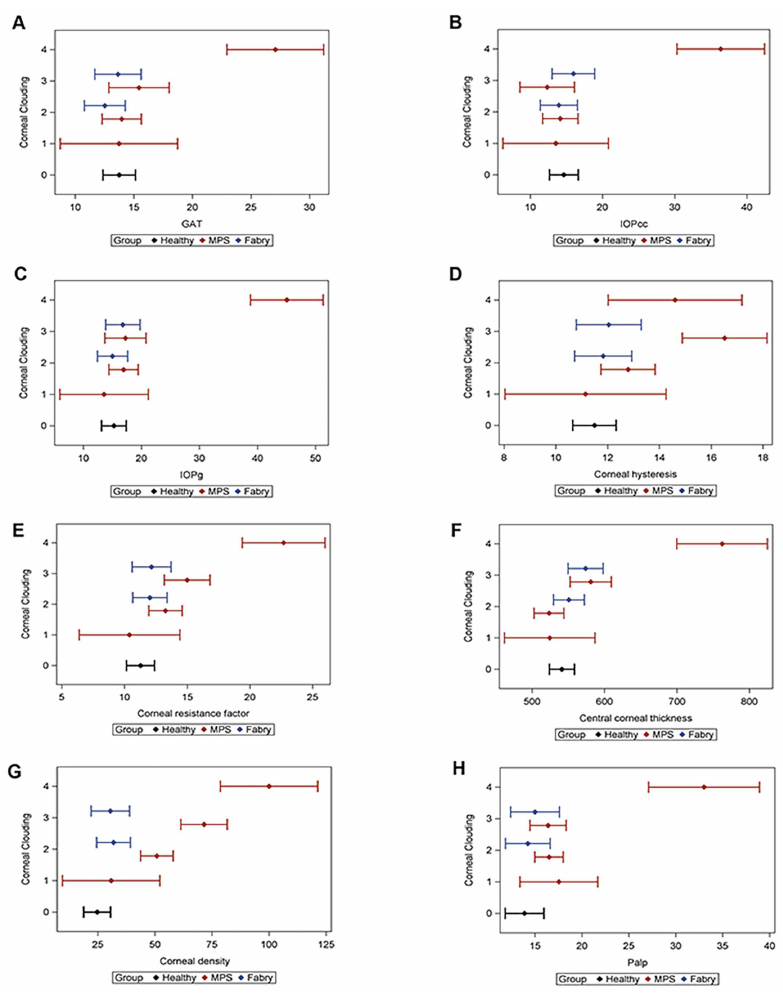
Fig 4. Association of GAT, IOPcc, IOPg, CH, CRF, CCT and density with diagnostic group and the grade of the corneal clouding. Estimated means and 95% confidenceintervals are shown.